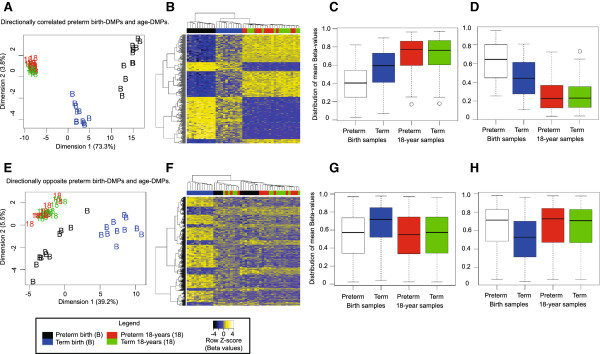
Comparison of correlated and directionally opposed birth and age differentially methylated probes (DMPs). (A) Multi-dimensional scaling (MDS) and (B) heatmap plots of 300 directionally correlated birth DMPs. Mean group β-values of correlated DMPs that (C) increased (159 probes) or (D) decreased (141 probes) with age. (E) MDS and (F) heatmap plots of 431 directionally opposed age and birth DMPs. Mean group β-values of directionally opposed DMPs that were (G) higher (314 probes) or (H) lower (117 probes) in term birth samples. The sample groups are color coded as follows: term birth, blue; preterm birth, black; term birth at 18 years, green; preterm at 18 years, red. Birth DMPs and age DMPs (defined using term group only) were analyzed by sub-setting probes that had changed in the same (correlated) or differing directions (opposing).